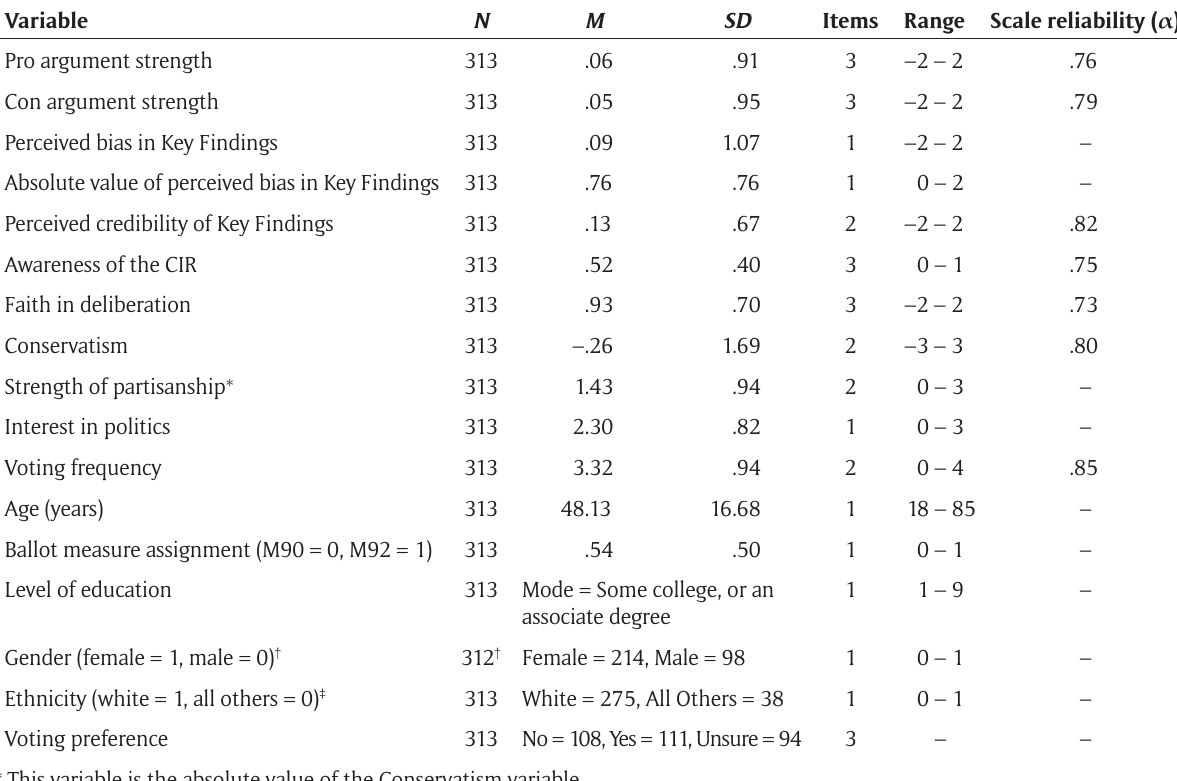
Table 1: Descriptive Statistics for All